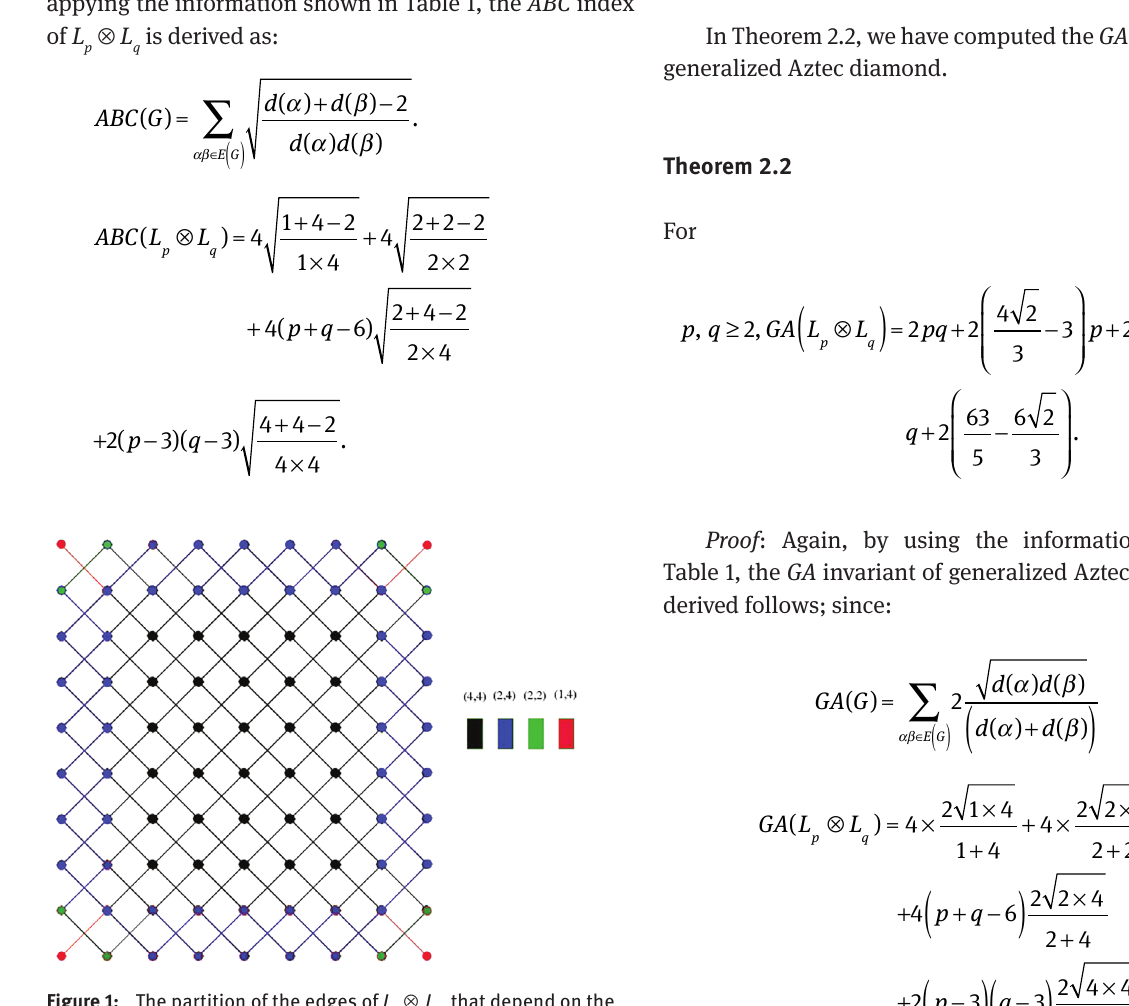
Figure 1: The partition of the edges of L degree of every end vertex of each edge.